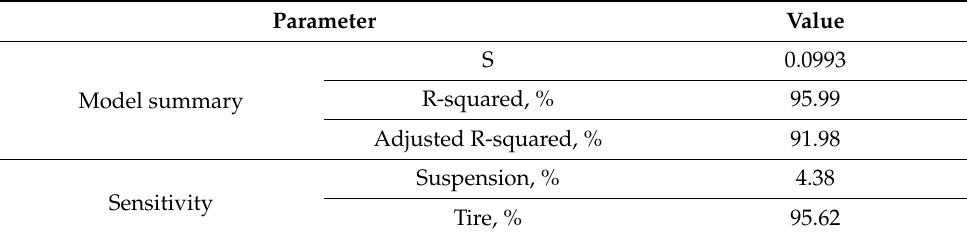
Table 9. Suspension and tire test results (double-lane change; side-slip